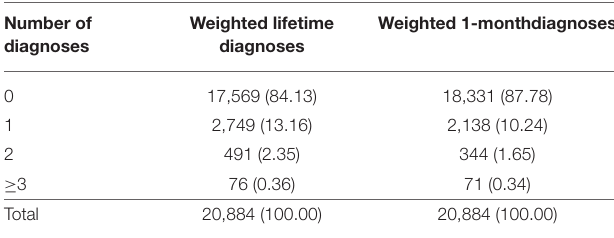
TABLE 7 | Comorbidity of the weighted lifetime and 1-month diagnoses of mental disorders [ n (%)]. Number of Weighted lifetime Weighted diagnoses diagnoses